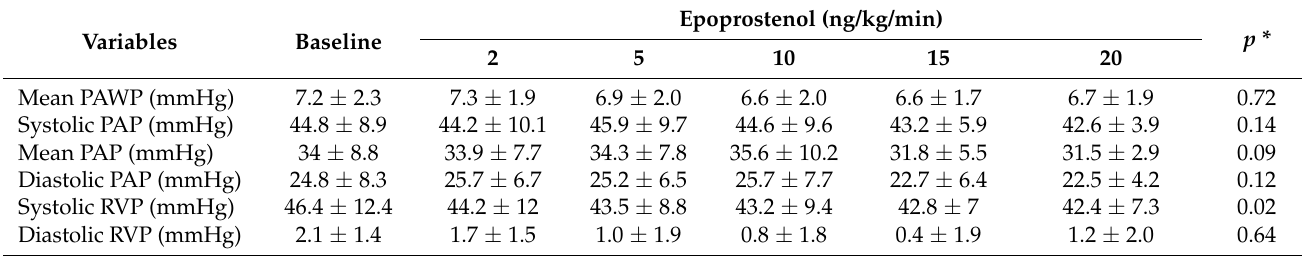
Table 1. Results of hemodynamic and echocardiographic variables before and after epoprostenol